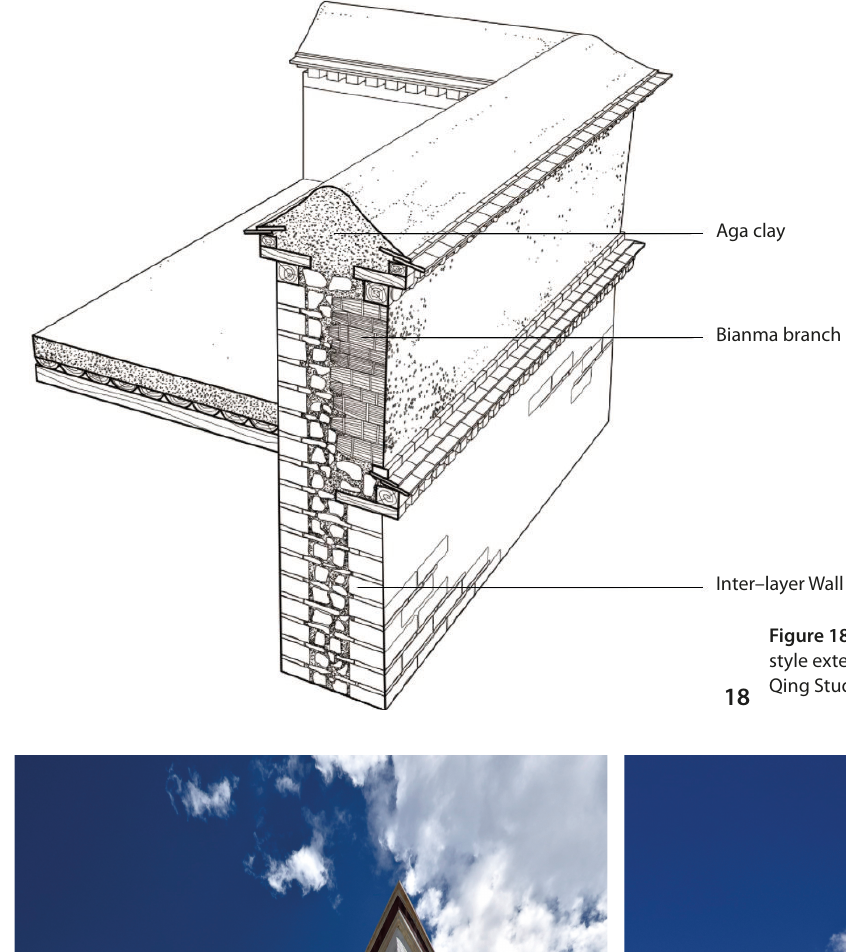
Figure 18 Decorative elements on the Tibetan style external wall, Bianma Wall (Source: Chang